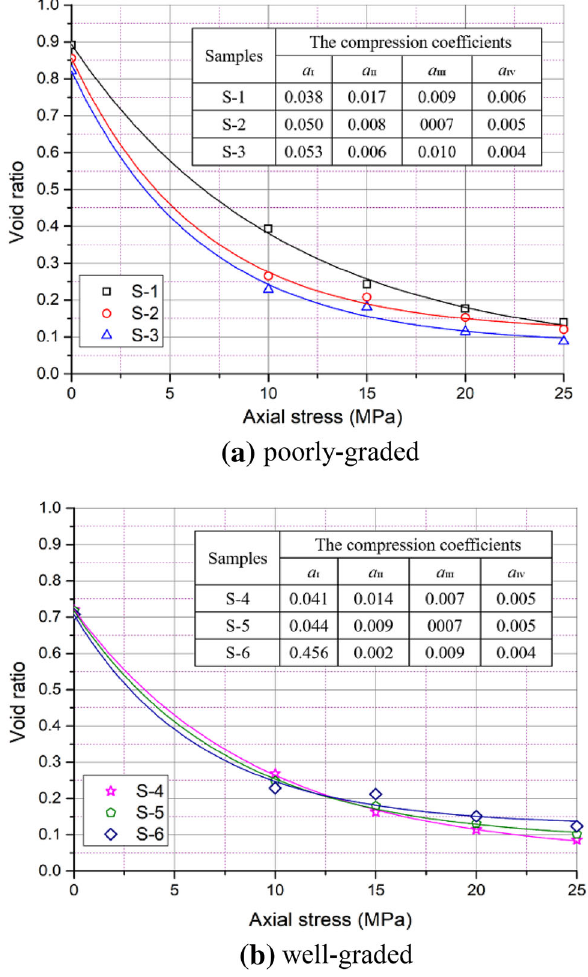
Fig. 6 The axial stress–displacement curves of crushed mudstones under step loading